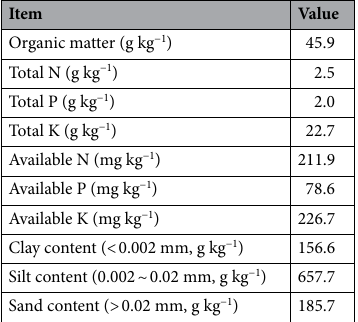
Table 2. Basic physicochemical properties of surface soil.